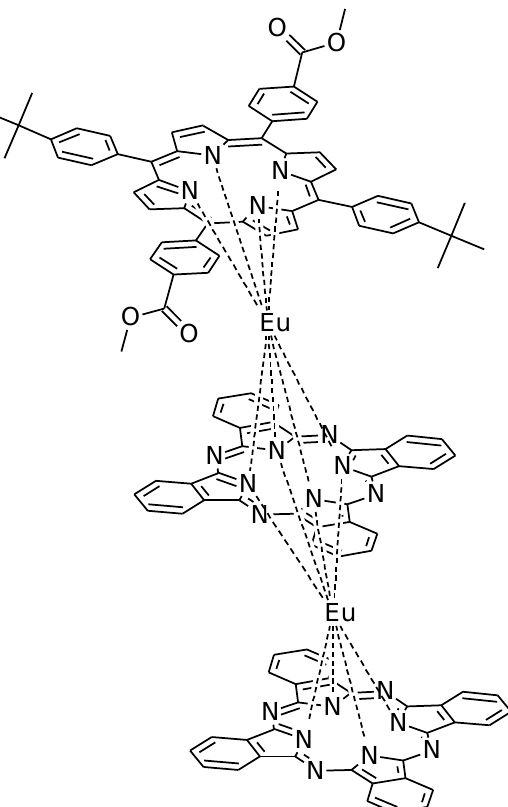
Figure 7. The chemical structure of the triple-decker phthalocyanine-porphyrin europium(III) com- plex [97].